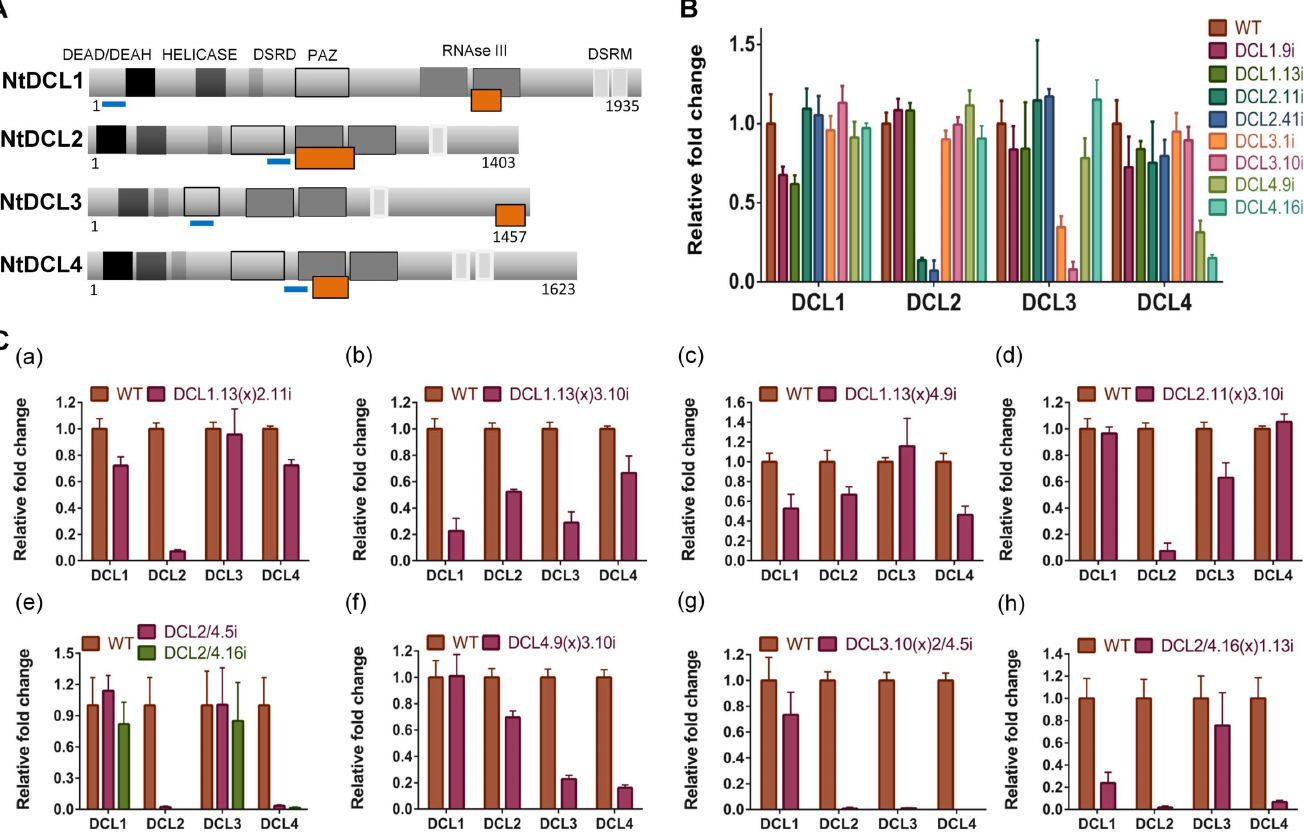
Fig 2. N . benthamiana DCLi plants have reduced levels of all targeted DCLs. (A) Schematic representation of N . benthamiana DCL proteins (based on information from [10]). Abbreviations stand for: DEAD-DEAH-DEAD box helicases, Helicase-Helicase C, DSRD-double-strandedRNA-binding domain, PAZ-Piwi ArgonauteZwille, RNAse III-RibonucleaseII, DSRM-double-stranded RNA-binding motif. The orange box represents the domain used to design the hairpins. The blue lines correspondto the selected fragment for qPCR analysis. (B) qPCR analysis of all DCLi single lines (n = 6). (C) qPCR analysis of F1 crosses line plants (n = 3–5) (a) DCL1.13(x)2.11i, (b) DCL1.13(x)3.10i, (c) DCL1.13(x)4.9i, (d) DCL2.11(x)3.10i, (e) DCL2/4.5i and DCL2/4.16i, (f) DCL4.9(x)3.10i, (g) DCL3.10(x)2/4.5i and (h) DCL2/4.16(x)1.13i. doi:10.1371/journal.ppat.1005936.g002 PLOS Pathogens | DOI:10.1371/journal.ppat.1005936 October 12,